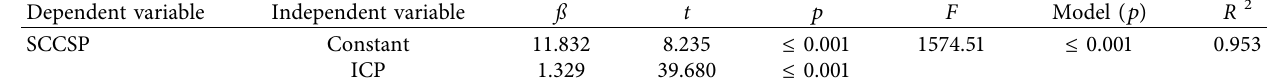
Table 3: Regression model of the efect of CP pressure levels on SCCSP measurements.